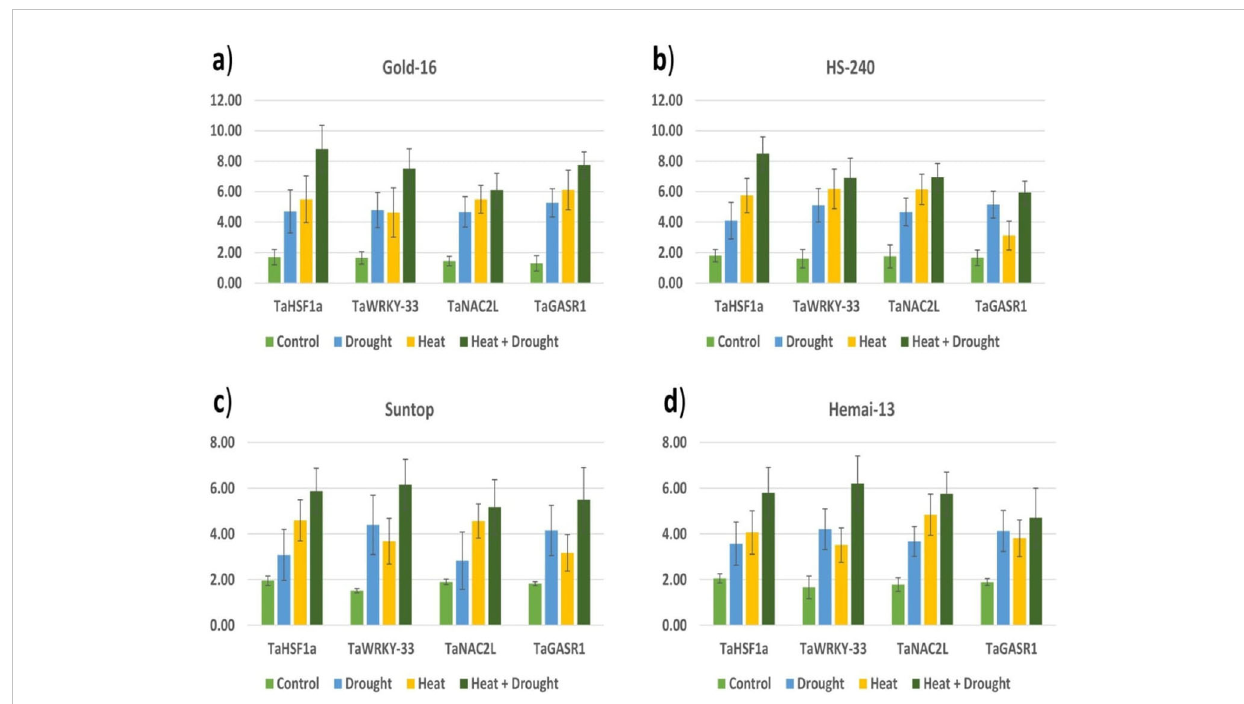
FIGURE 9 Varying expression patterns of drought- ( TaWRKY-33 and TaGASR1 ) and heat- ( TaHSF1a and TaNAC2L ) associated genes under the control treatment and individual and combined applications of drought and heat stress in four different wheat genotypes (A – D)